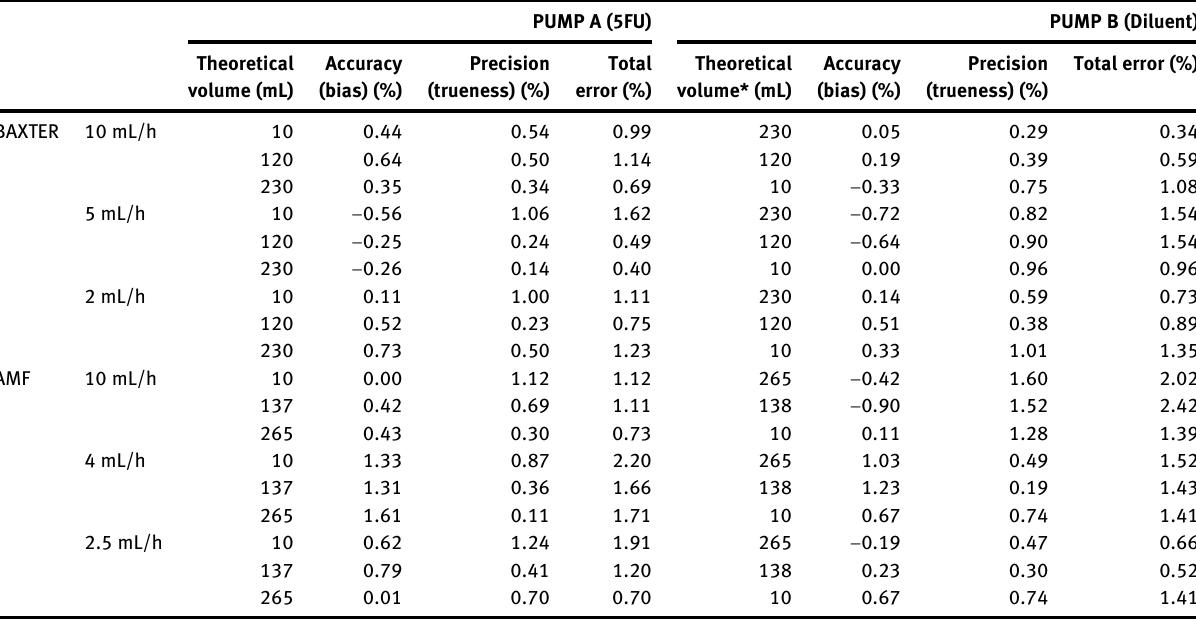
Table  : Accuracyofthevolumesadministeredbythepumps(eachvaluesofaccuracy,precisionandtotalerrorarebasedontheresultsofthe nine repetitions (  times at start, middle and end of